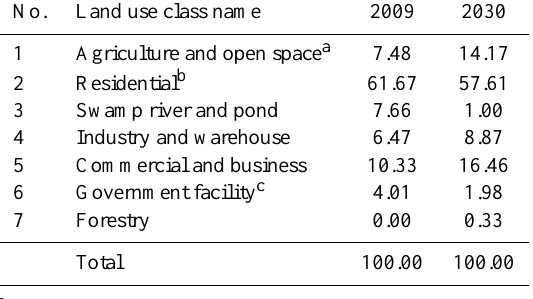
Table 2. Area per land use class compared to total area of Jakarta (%) for the baseline land use map 2009 and the Spatial Plan 2030. Several of the original land use classes were reclassed as per the notes under the table.